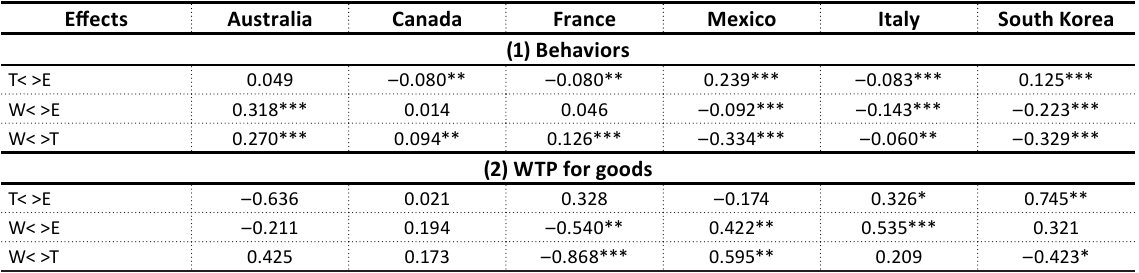
Table 4. Average discrete effects of binary probit, dependent variable: engagement in pro- environmental behavior above the median (1), parameter estimates of ordered probit with random effects, dependent variable: WTP for pro-environmental goods (2)